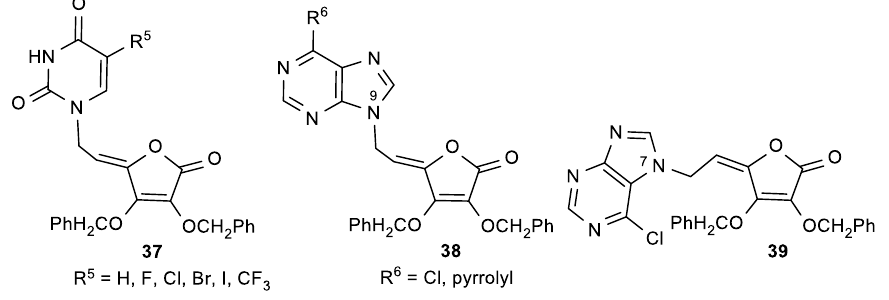
18 , Figure 7) [114]. It was found that